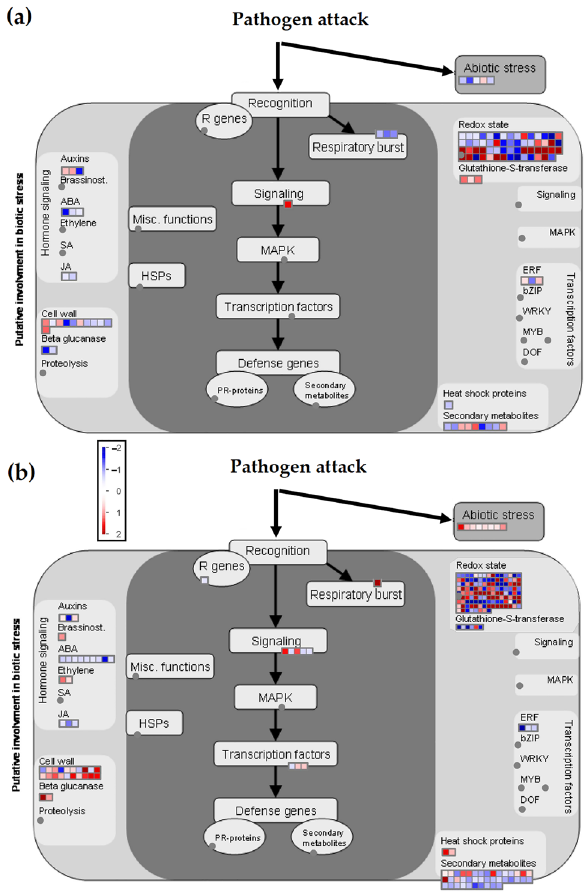
Figure 3. MapMan analysis of changes in biotic stress-associated transcript expression in potato cultivars after 42 days in response to root infection by S. subterranea . The log2 fold change of DEGs in ( a ) Gladiator and ( b ) Iwa were mapped to the MapMan biotic stress. The colour scale is shown in middle. A plant’s response to the pathogen attack includes a few steps: recognition of pathogen signal by the related receptors (R genes); induction of the transcription of the cascade of plant immune system including oxidative stress changes; the transition of signals to lead to the production of defense molecules including PR-proteins, secondary metabolites, and heat shock proteins. The big grey circle is an illustrated map of the nucleus, and the small grey circle indicates an annotated biological process. Square blocks represent genes, with up and downregulation marked by red and blue, respectively. Dark grey fields indicate that none of the expressed genes could be assigned to the respective class. ABA, abscisic acid; MAPK, mitogen-activated protein kinase; SA, salicylic acid; JA, jasmonic acid; HSPs, heat shock